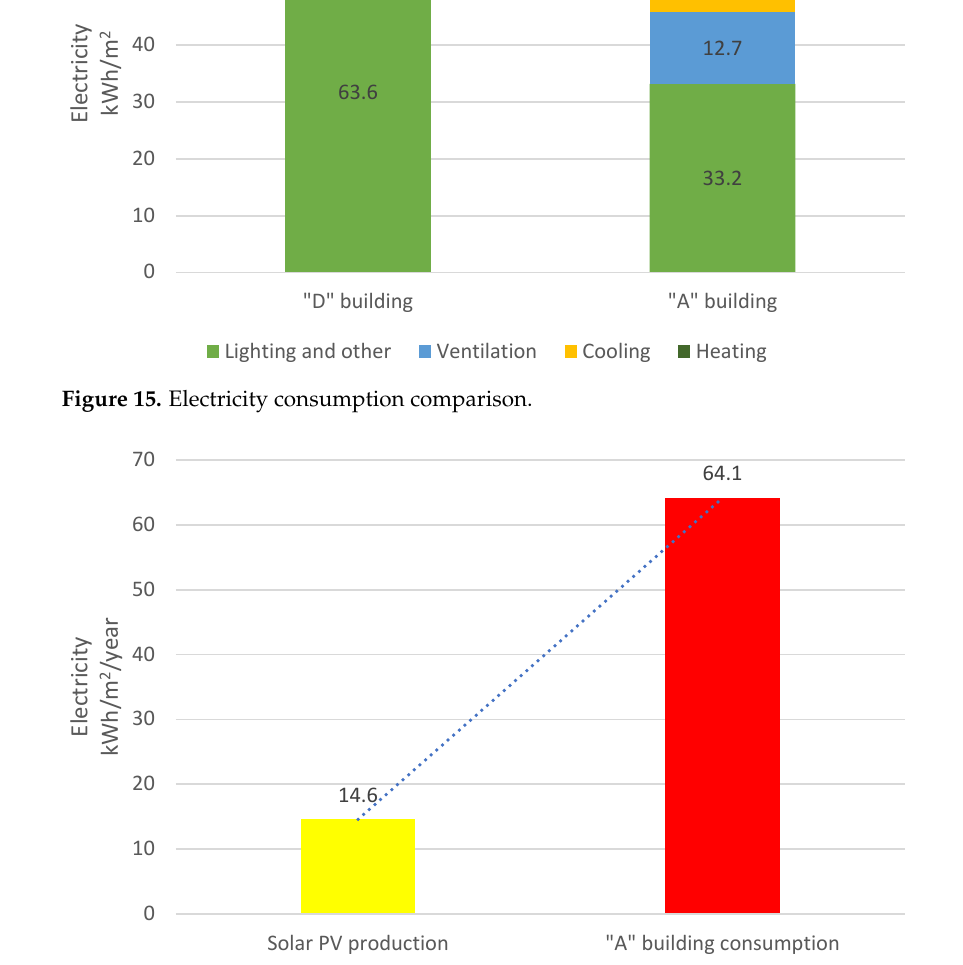
Figure 16. Solar power plant (PV) generation and total electricity consumption .